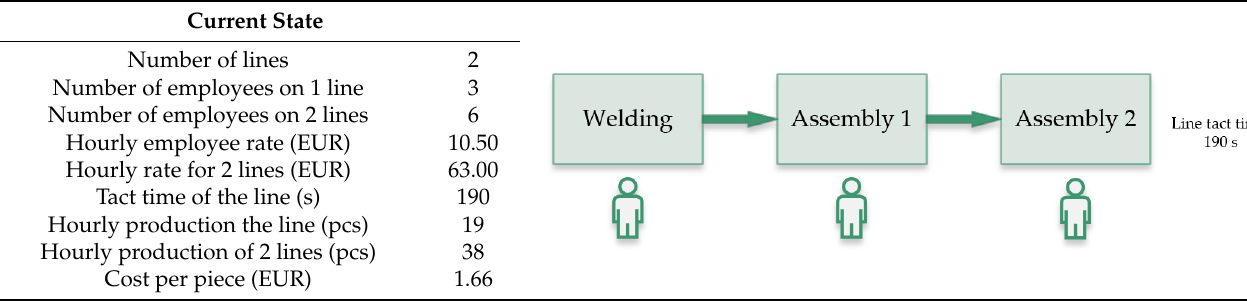
Table 2. Current state of assembly.